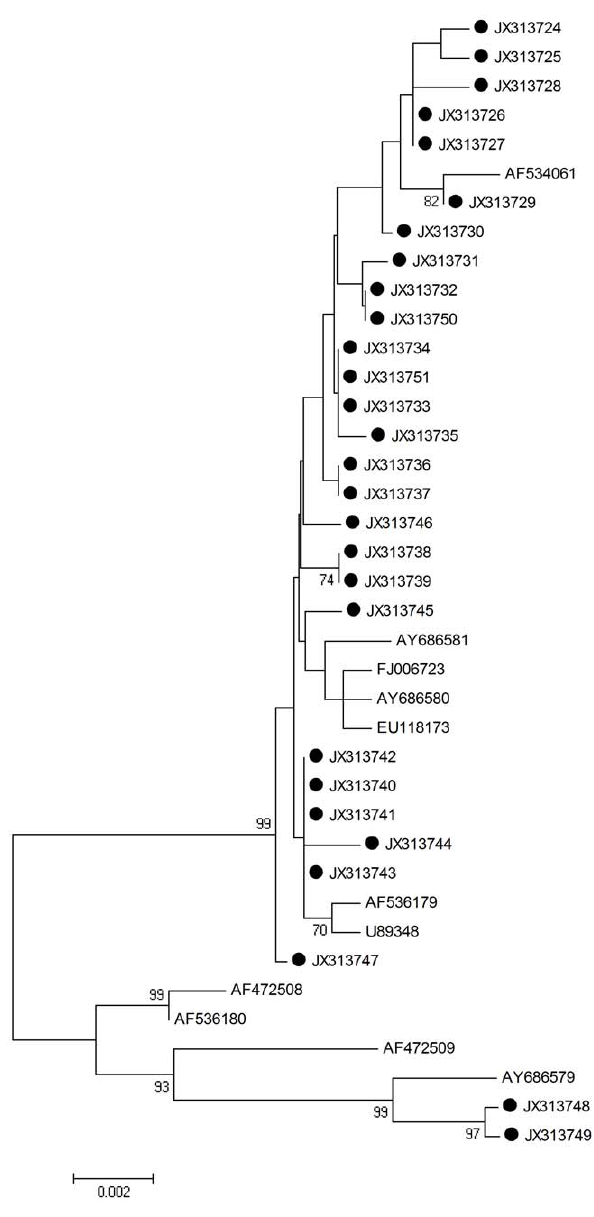
Figure 2. Neighbor joining phylogenetic tree generated using nucleotide sequences of the HPV-16 L2 gene. Study sequences are labeled in black. Others are standard sequences, including: AY686580, FJ006723 (China, Xinjiang), AY686581, EU118173, AF534061, U89348, AF536179, AF472508, AF536180, AF472509, and AY686579. Phylogenetic trees were constructed by the Neighbor- Joining method and the Kimura 2-Parameter model by MEGA package.